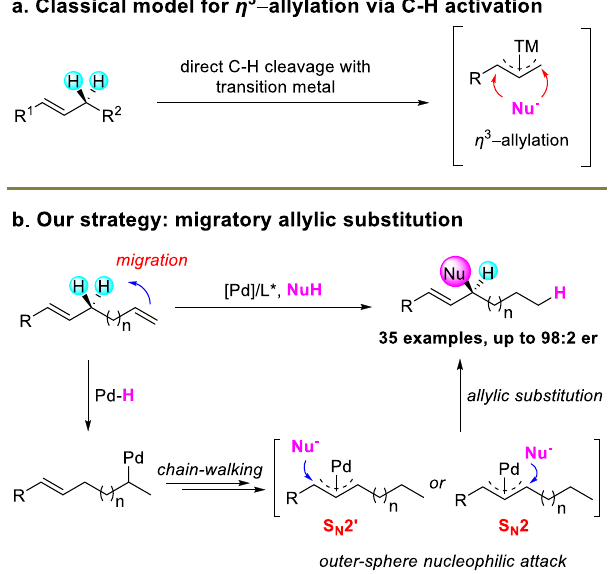
Fig. 1 Transition metal-catalyzed allylic C − H substitution. a Classical model for enantioselective transition metal-catalyzed allylic C − H substitution. b Our strategy: metal migration triggers allylic C(sp 3 )-H functionalization. NuH,